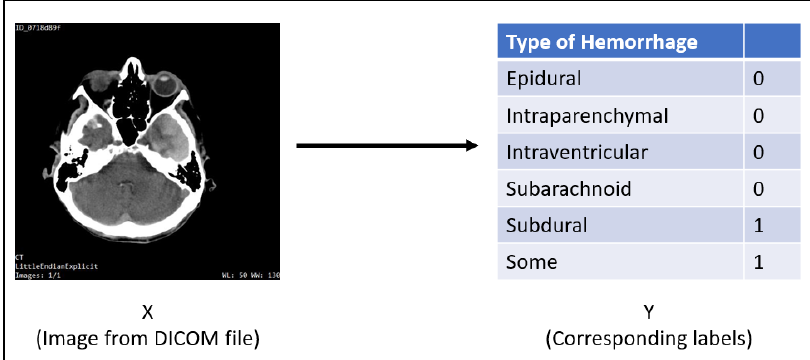
Figure 2. Illustration showing an example of Input/Output for the Neural Networks.